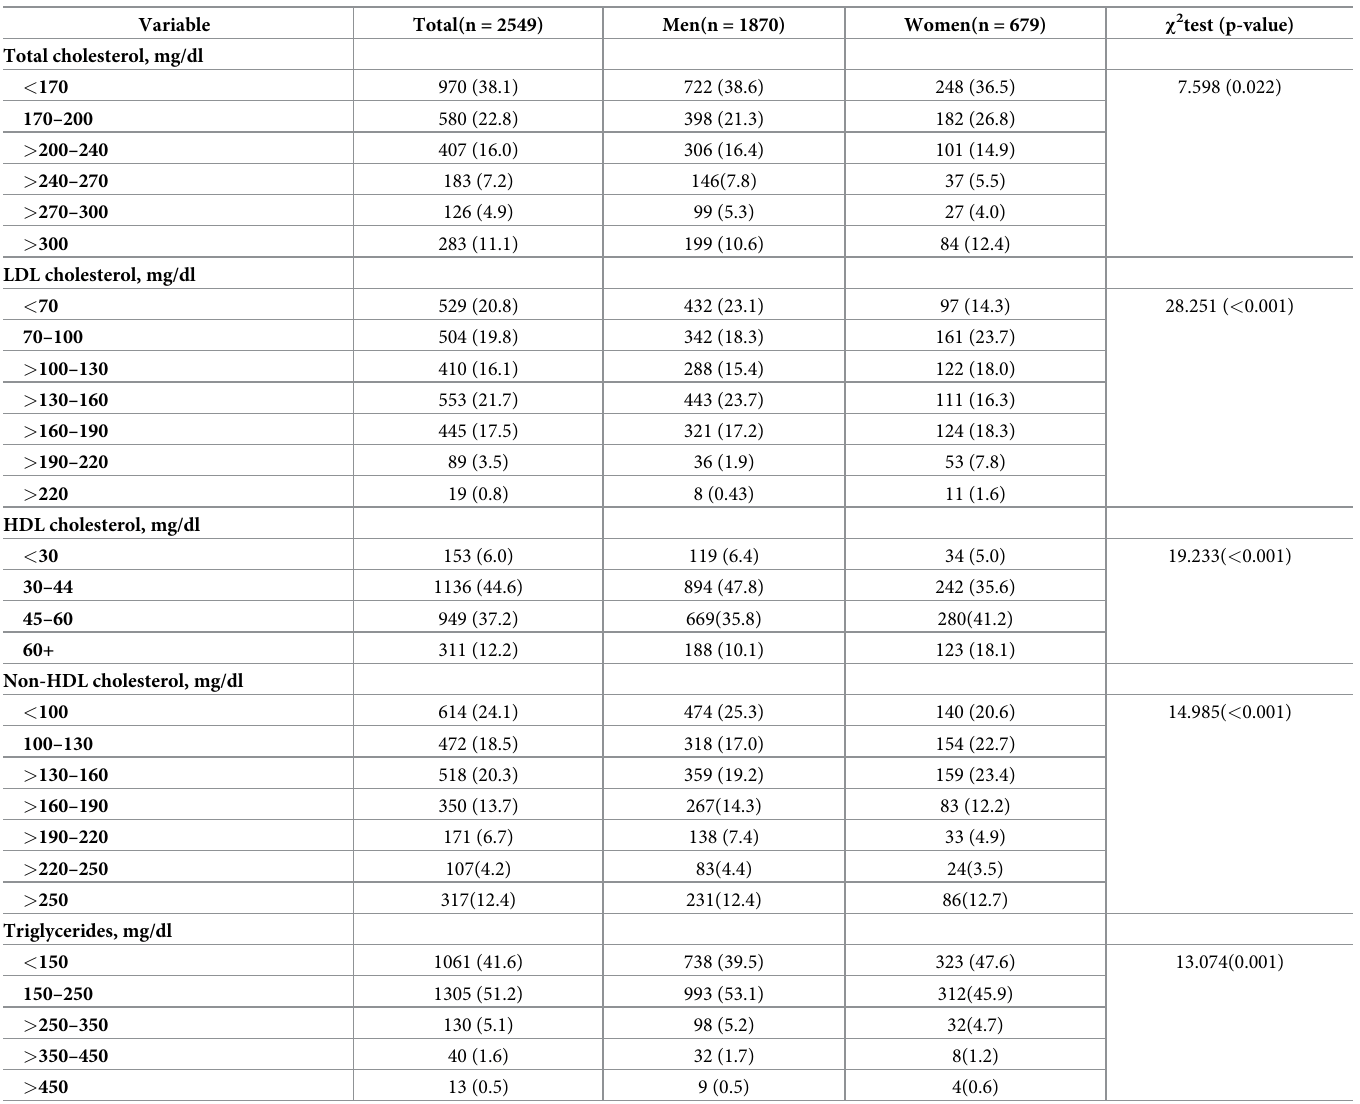
Table 1. Cholesterol lipoproteins and triglycerides in the study